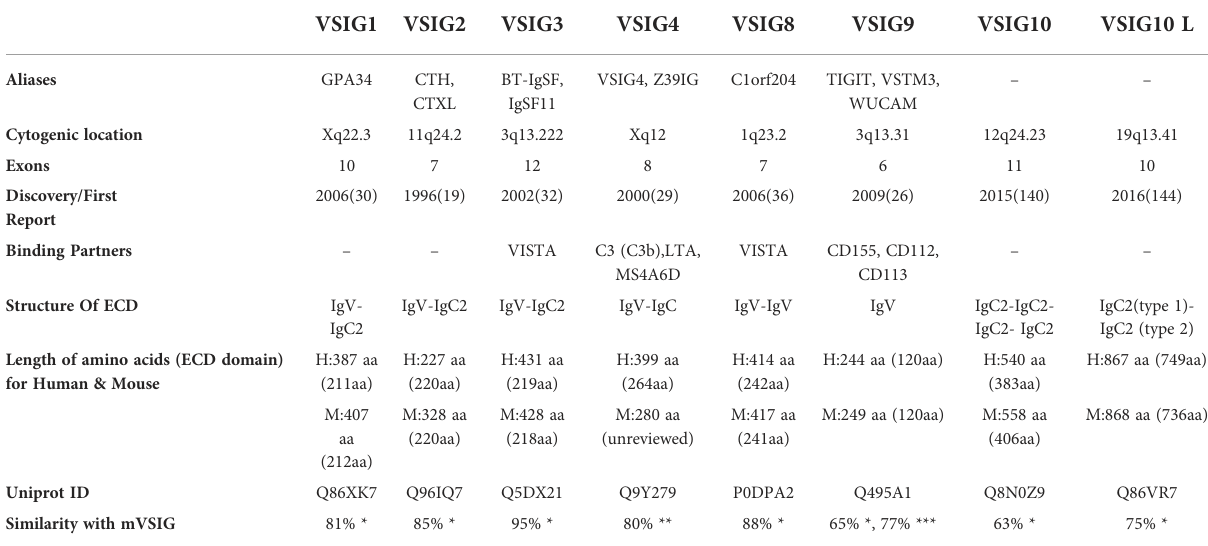
TABLE 1 Brief overview of VSIG family